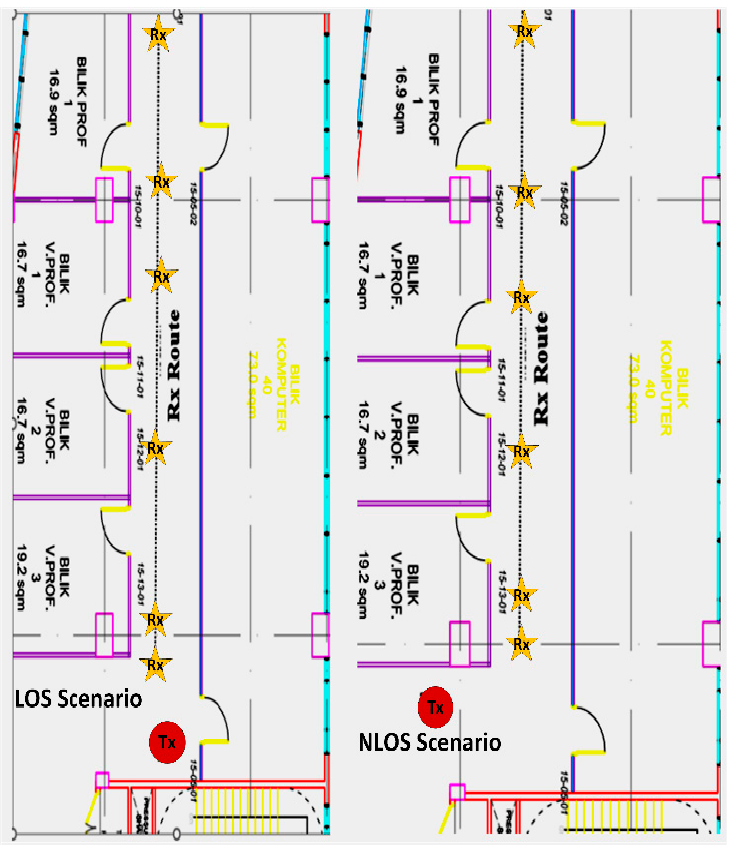
Figure 3. Floor Plan for Measurement Environment.